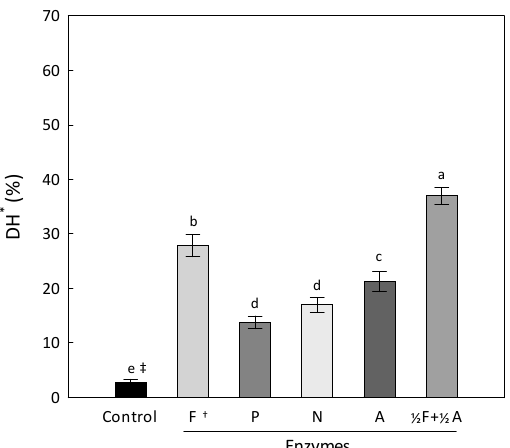
Figure 2. The degree of hydrolysis of the protein in the residues using different commercial proteases. Data are expressed as the mean ± SD of three samples. * Degree of hydrolysis. Control was treated without any enzyme. † F, flavourzyme 2%; P, protamex 2%; N, neutrase 2%; A, alcalase 2%; 1 / 2 F + 1 / 2 A, flavourzyme 1% plus alcalase 1%. ‡ Different letters indicate significantly different values ( p < 0.05). The enzymatic hydrolysis was conducted under the following conditions: pH,